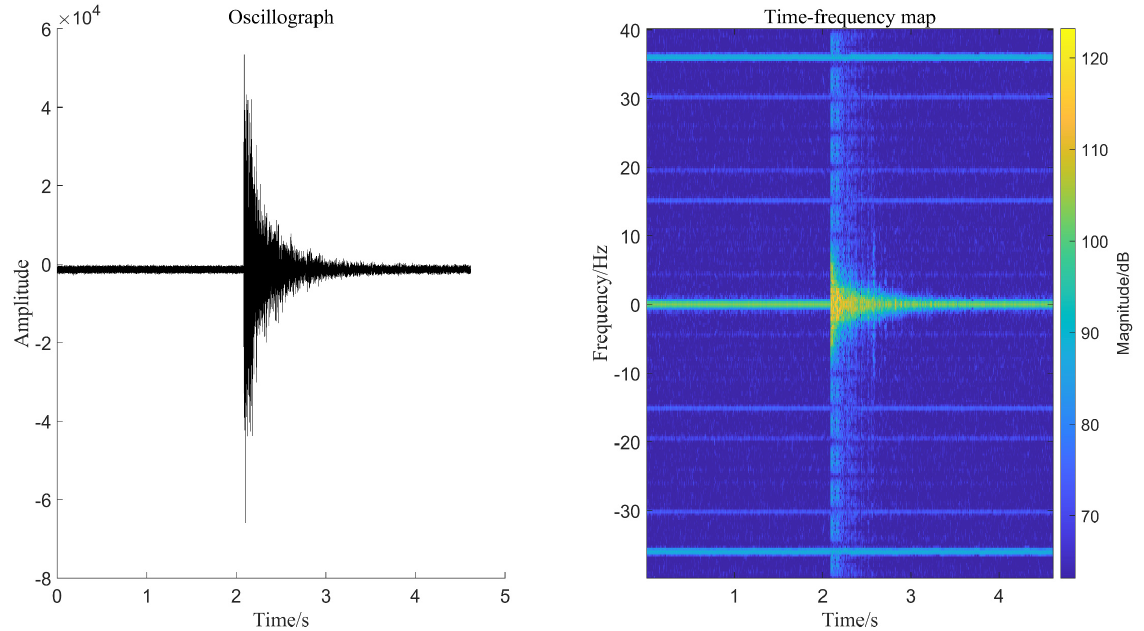
Figure 5. Oscillograph and time-frequency diagram.